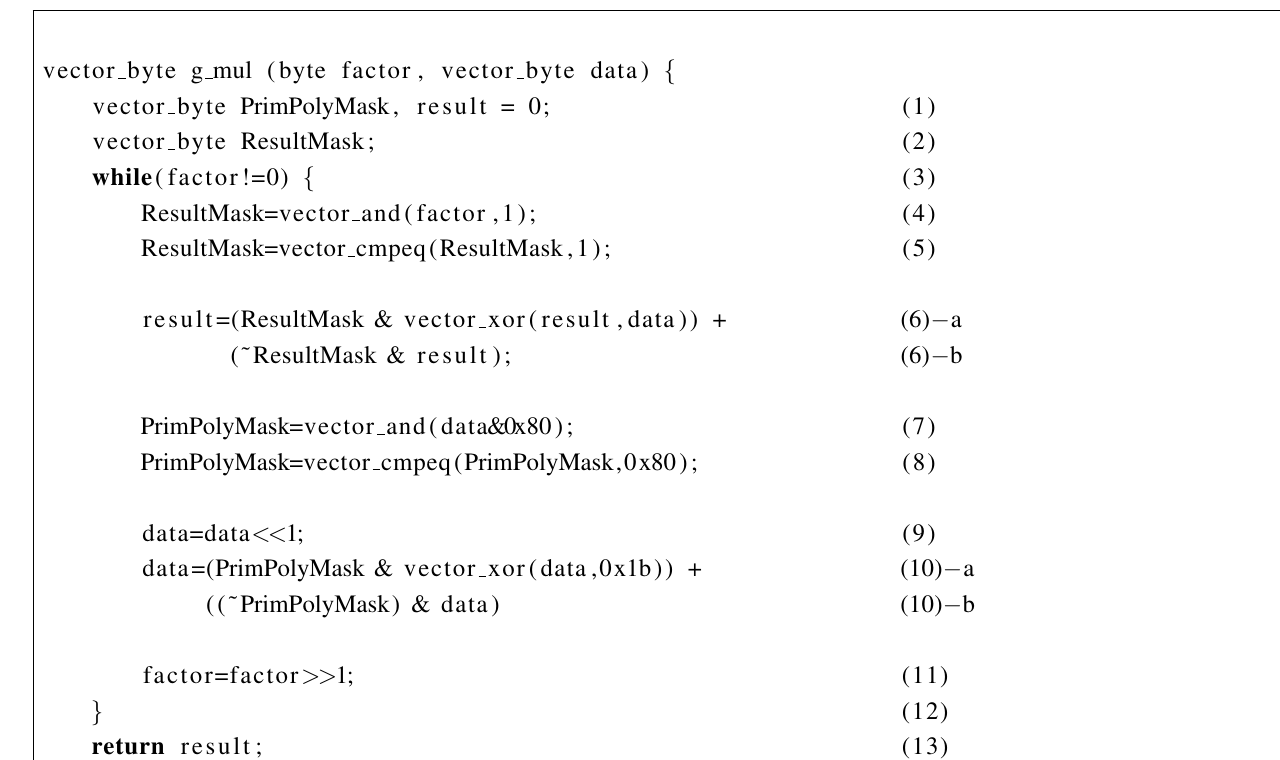
Figure 9. The loop-based SIMD multiplication in GF( 2 8